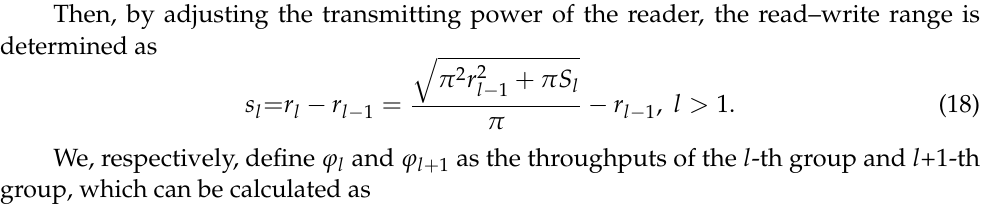
Figure 4. The tag grouping method based on the adaptive power control for the